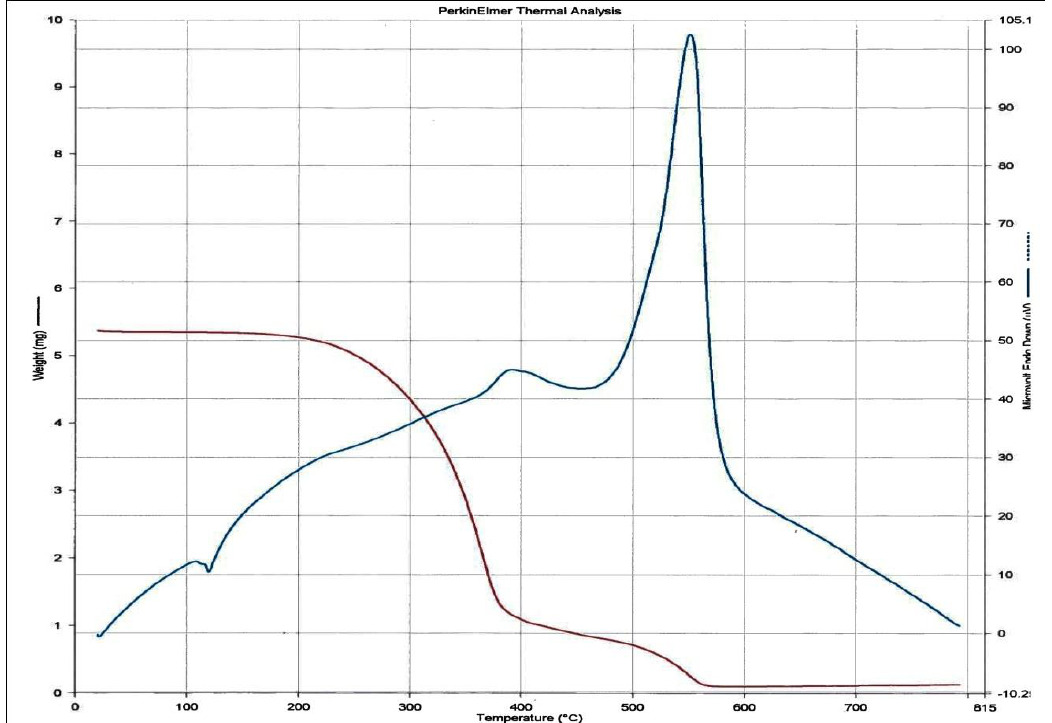
Figure S25: TG/DTA graph of diketone monomer o